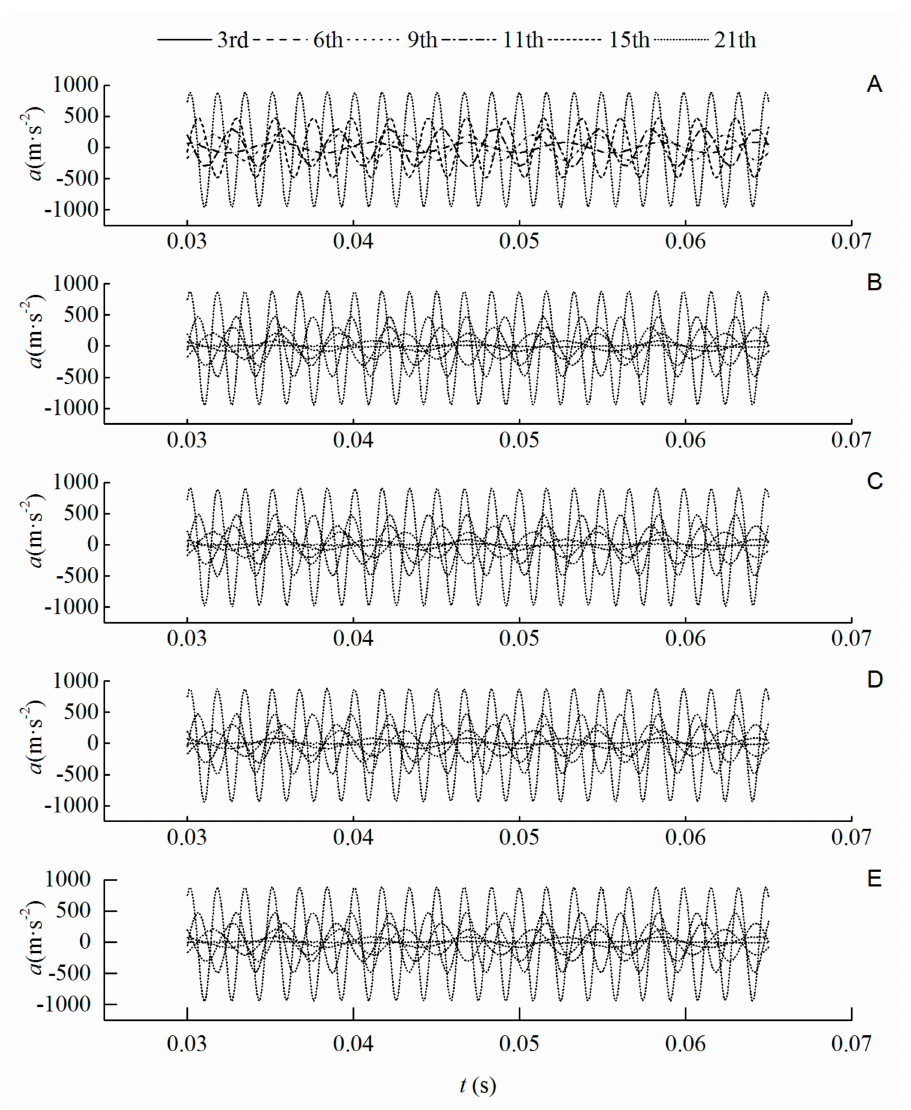
Figure 10. Time histories of vertical vibration acceleration at points A to E for various harmonic